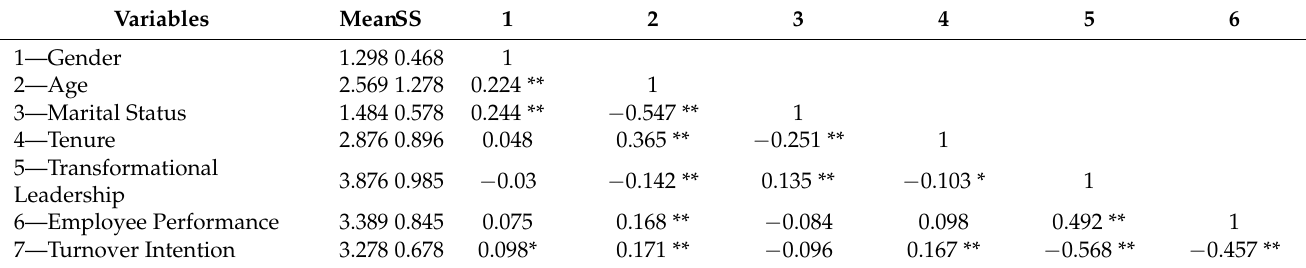
Table 2. Relations among